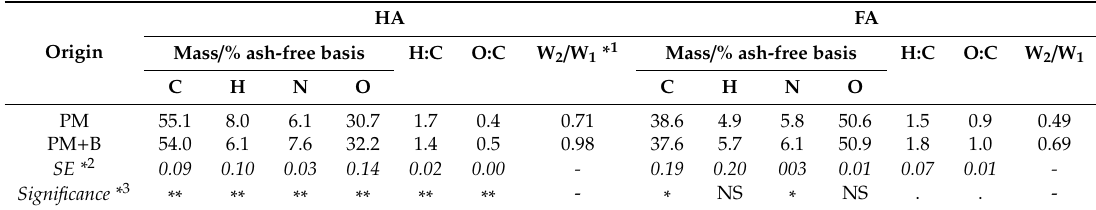
Table 2. The elemental composition and thermogravimetric ratio of humic acid-like (HA) and fulvic acid-like (FA) extracted from poultry manure compost (PM) and poultry manure blended with biochar (PM +